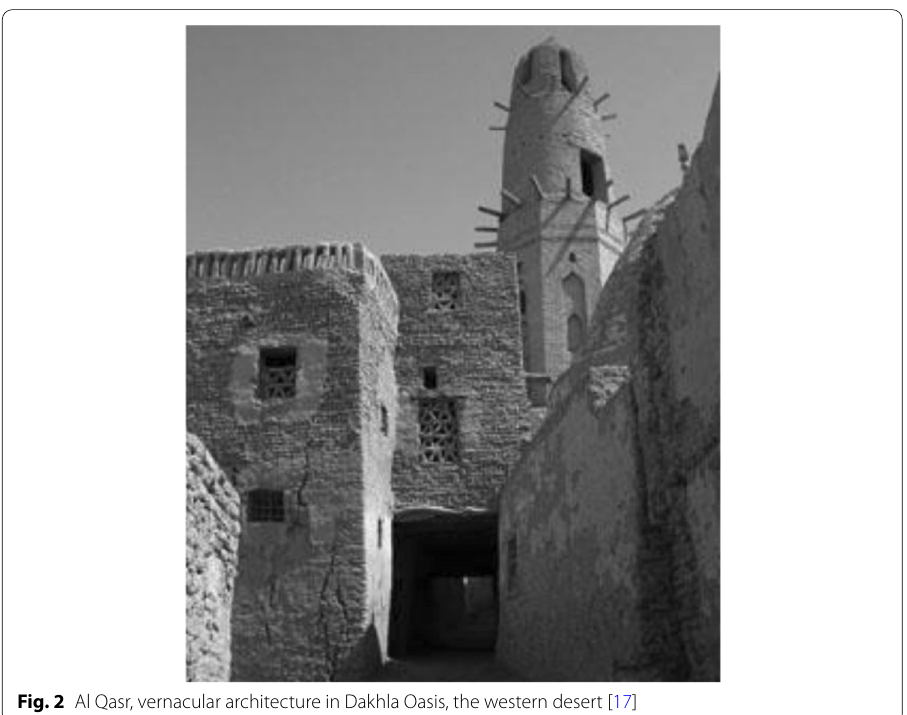
Fig. 2 Al Qasr, vernacular architecture in Dakhla Oasis, the western desert [17]